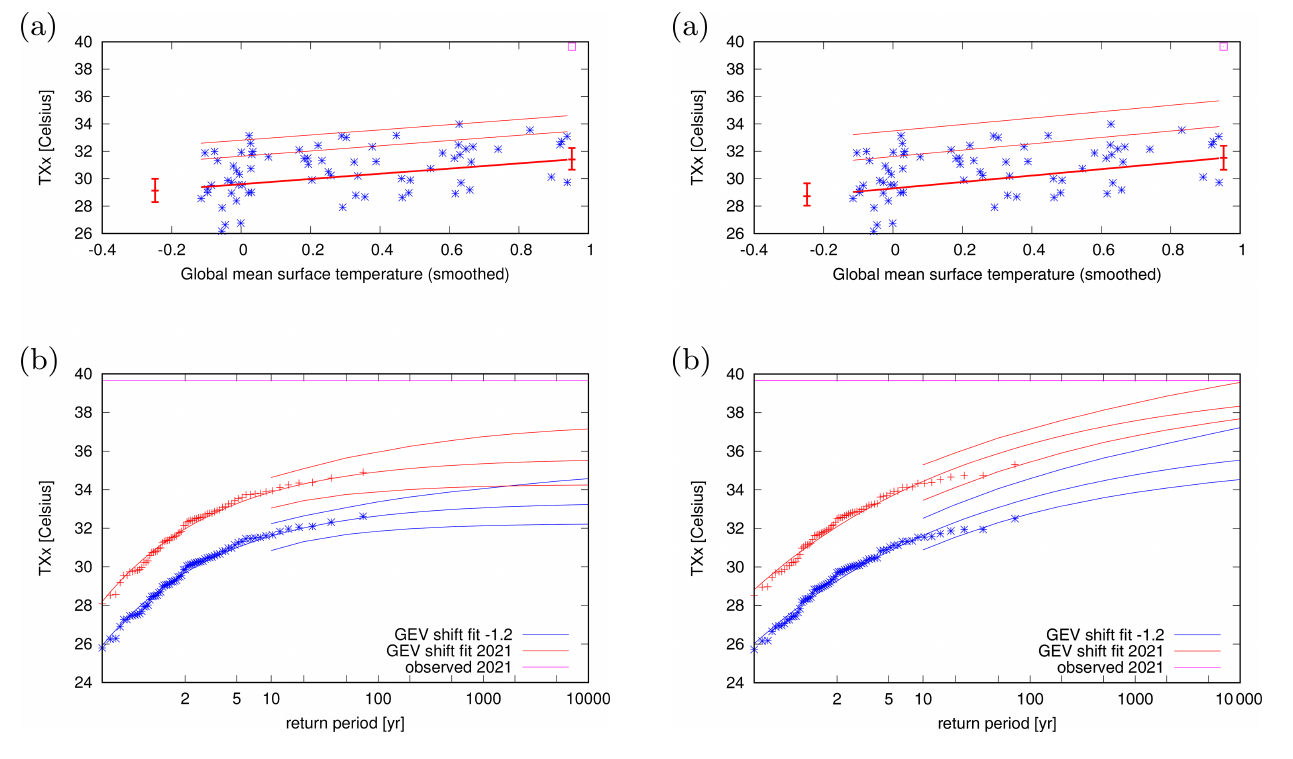
Figure 6. GEV fit with constant scale and shape parameters and lo- cation parameter shifting proportional to GMST of the index series. No information from 2021 is included in the fit. (a) The observed TXx as a function of the smoothed GMST. The thick red line de- notes the location parameter, the thin red lines the 6- and 40-year return period levels. The June 2021 observation is highlighted with the magenta square and is not included in this fit. (b) Return pe- riod plots for the climate of 2021 (red) and a climate with GMST 1.2 ◦ C cooler (blue). The red and blue lines indicate the best fit and the 95% confidence intervals; the magenta line shows the observed value. The past observations are shown twice: once shifted up to the current climate and once shifted down to the climate of the late 19th century. Source: ERA5 (Hersbach et al., 2019); fit: KNMI Climate Explorer (https://climexp.knmi.nl, last access: 22 April 2022).